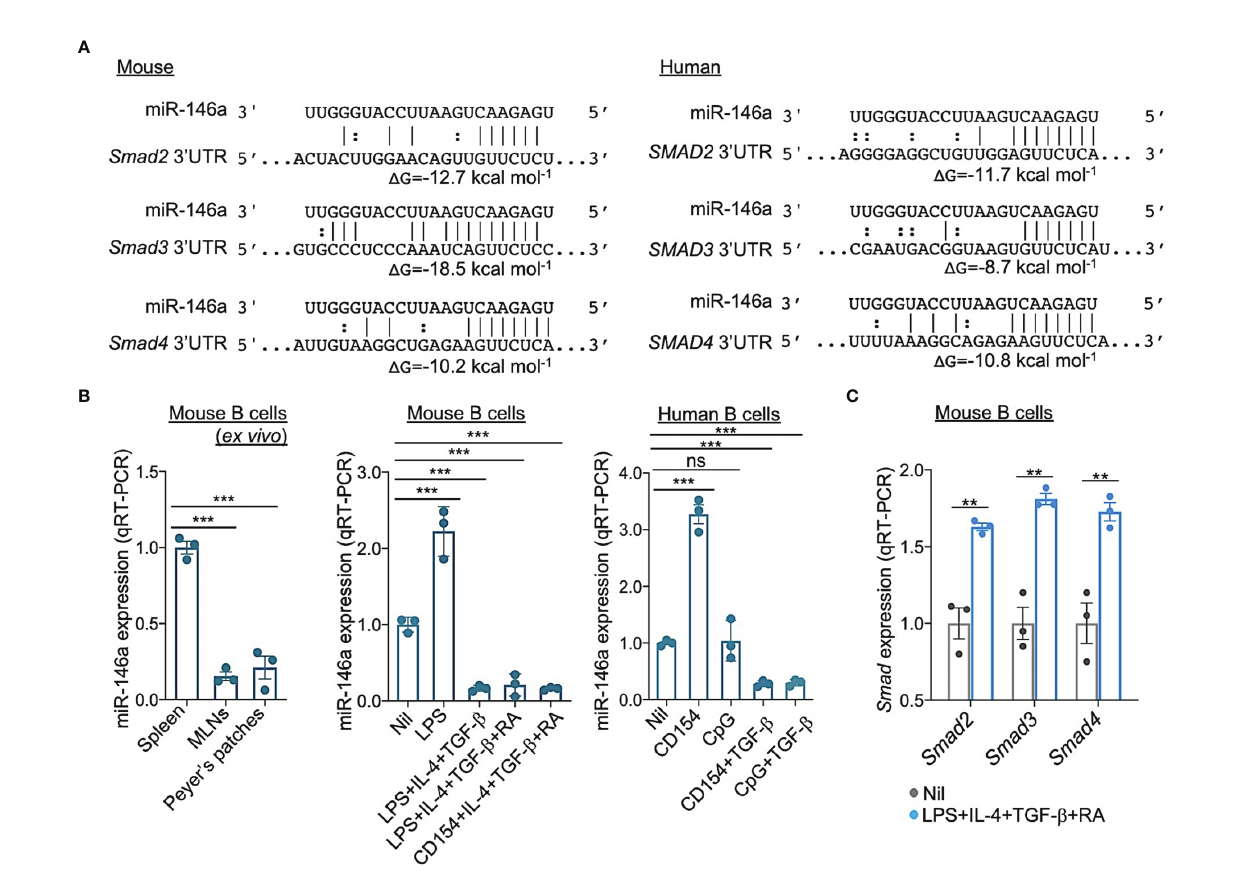
FIGURE 6 | miR-146a targets 3 ’ UTR of Smad2, Smad3 and Smad4 mRNAs and is downregulated by the stimuli that induce CSR to IgA in human and mouse B cells. (A) Alignment of miR-146a with its target sites in the 3 ′ UTR of human and mouse SMAD2/Smad2 , SMAD3/Smad3 and SMAD4/Smad4 mRNAs. The complementary base pairing between miRNA-146a and seed sequences within the 3 ’ UTRs of SMAD2/Smad2 , SMAD3/Smad3 and SMAD4/Smad4 , indicating miR-146a ability to silence SMAD2/Smad2 , SMAD3/Smad3 and SMAD4/Smad4 transcripts. Gibbs free energy ( D G ) of nucleic acid folding and hybridization calculated by Mfold. Watson – Crick base-pairing ( “ | ” ); wobble base-pairing ( “ : ” ). (B) Expression of miRNA-146a in mouse spleen, MLN and Peyer ’ s patch B cells ex vivo ; and in mouse spleen B cells stimulated for 72 h with Nil, LPS, LPS plus IL-4 and TGF- b , LPS or CD154 plus IL-4, TGF- b and RA, or human B cells stimulated for 72 h with Nil, CD154, CpG, and CD154 or CpG plus TGF- b , as analyzed by qRT-PCR. Values were normalized to expression of small nuclear/nucleolar RNAs Rnu6, Snord61, Snord68, and Snord70, and depicted as relative to the expression of miRNA-146a in spleen B cells stimulated with Nil, set as 1. (C) Expression of Smad2, Smad3 and Smad4 transcripts in mouse B cells stimulated for 72 h with Nil or LPS plus IL-4, TGF- b and RA, as analyzed by qRT-PCR and normalized to b - Actin , and depicted as relative to the expression of these genes in spleen B cells stimulated with nil, set as 1. Data are mean ± SEM from three independent experiments. *** p < 0.001, ** p < 0.01, ns, not signi fi cant, unpaired t